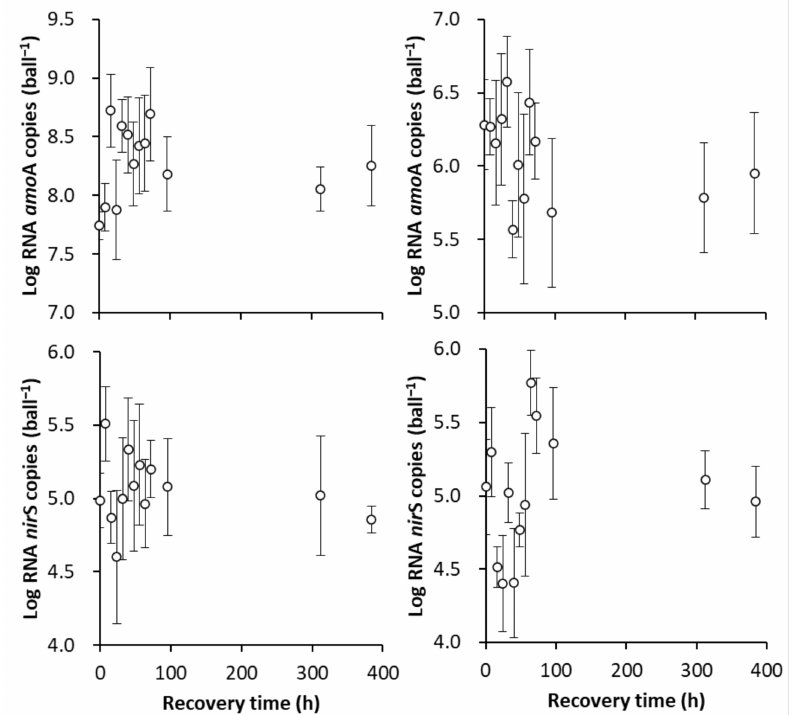
Figure 10. The recovery of the original stable state (SS) of the RNA level abundance of nitrogen-cycle functional genes amo A and nir S after the one-day aeration or no aeration interruption. ( A , B ) show the recovery of the original SS of the RNA level abundances of amo A and nir S, respectively, in the AE-D reactors; ( C , D ) show the recovery of the original SS of the RNA level abundances of amo A and nir S, respectively, in the AN-D reactors. (sample number:13).